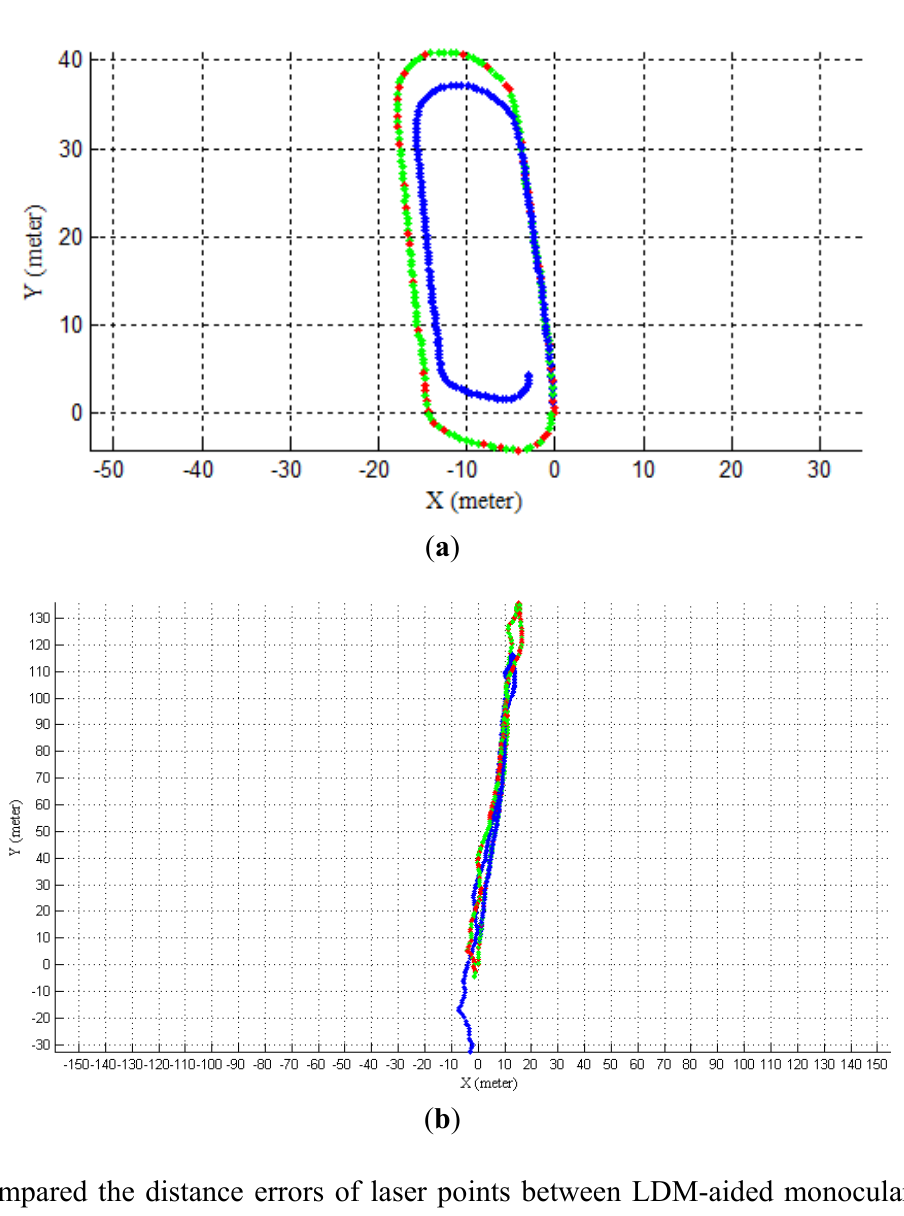
Figure 13. Estimated trajectory using monocular VO (blue); estimated trajectory using enhanced monocular VO (green); red dots represent frames when the synchronized laser pointer was successfully matched and scale correction was taken. ( a ) the first dataset; ( b ) the second